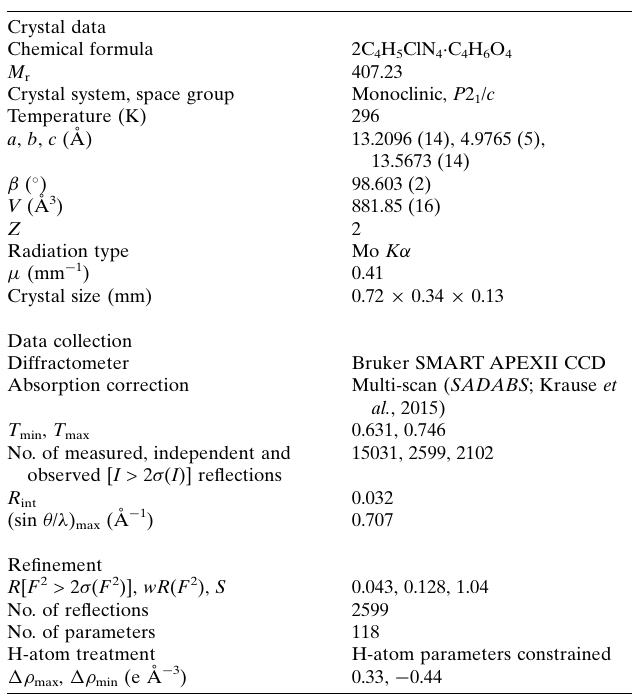
Table 2 Experimental